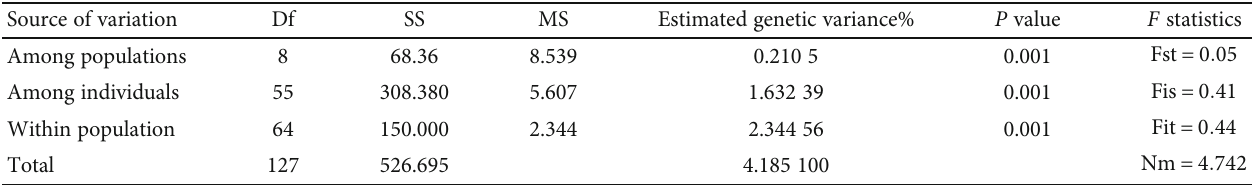
Table 3: Analysis of molecular variance (AMOVA) based on standard permutation across the full data set of tef accessions collected from di ff erent geographical origins.